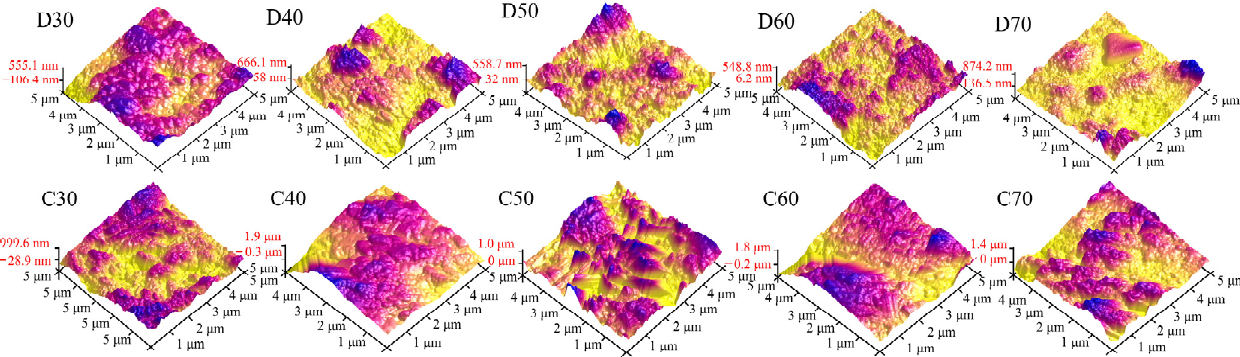
Figure 11. Average roughness of the deposition products (D30 − D70) and calcination products (C30 − C70). 3.2. Properties of Ti6Al4V/SrFHA Composites 3.2.1. Adhesion Strength and Microhardness The adhesion strength and Vickers microhardness of D30 − D70 and C30 − C70 are shown in Figure 12. Evidently, D50 showed the lowest adhesion strength, 0.68 MPa, due to the highest amount of SrFHA. It should be mentioned that the higher adhesion strength of other deposition products was not an effective indicator of adhesion of the SrFHA coat- ing to the substrate due to much less amount of deposited SrFHA. For instance, for D30 and D70, their adhesion strength was close to that of the titanium alloy to the binder in- stead of the coating. For the same reason, the Vickers microhardness of deposition prod- ucts showed a similar changing trend. It varied within a limited range from 323 HV to 399 HV, all meeting the requirement for dental applications [45]. Some samples even showed a higher Vickers microhardness than Ti6Al4V (380.5 HV) [46]. For the calcination products (C30 − C70), they showed smaller variations of adhesion strength and Vickers microhard- ness. Their adhesion strength varied between 2.41 MPa (C50) and 2.91 MPa (C30), all higher than (1.9 MPa) the similar composite previously reported [41]. C30, C40, and C70 possessed lower adhesion strength than the corresponding deposition products mainly due to the formation of titanium oxide. However, the other calcination products, espe- cially C50, showed higher adhesion strength than the corresponding deposition products. It could be attributed to mechanical interlocking associated with the higher crystallinity